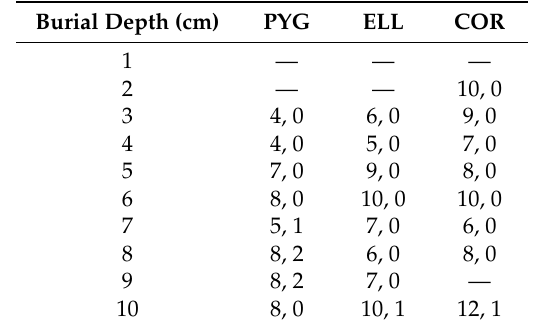
Table 5. Escape potential data for coarse sand (0 Φ ≥ grain size ≥ 1 Φ ). PYG— Pyganodon cataracta ; ELL— Elliptio complanata ; COR— Corbicula fluminea. In columns 2–4, the number to the left of the